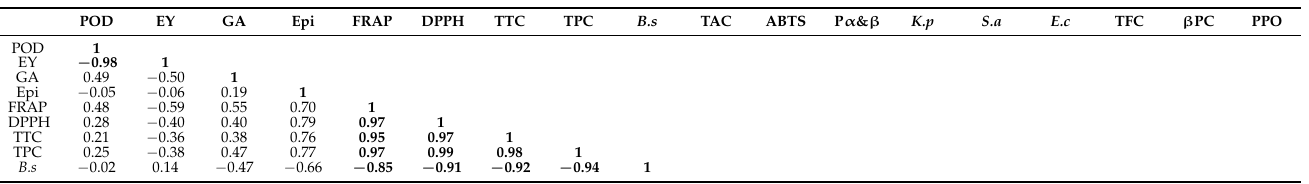
Figure 5. Individual phenolic and flavonoid concentration from three different cultivars, namely ‘Wonderful’, ‘Acco’, and ‘Herskawitz’ pomegranate peel at ripe harvest maturity blanched at 80 °C for 3 min. Graphs represent concentrations in mg/g DM for ( a ) punicalin α and β ; ( b ) α -punicalagin; ( c ) β -punicalagin; ( d ) ellagic acid; ( e ) catechin; ( f ) Epicatechin; and ( g ) gallic acid. Bars with different letter(s) represent statistical differences ( p < 0.05) using Duncan’s multiple range test. Table 4. Pearson’s correlation matrix between chemical indices measured from blanched (80 ◦ C for 3 min) ‘Acco’, ‘Herskawitz’, and ‘Wonderful’ pomegranate